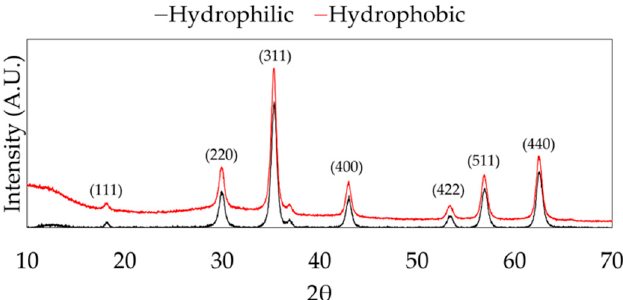
Figure 2. X-ray diffraction spectra of hydrophilic and hydrophobic nanoparticles. The peaks in both results matched with crystallography open database peaks associated with magnetite (Fe 3 O 4 ).